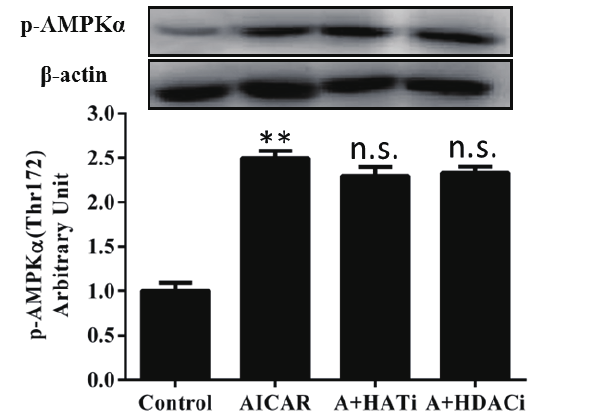
Figure 1. Antemortem injection of AICAR activated AMPK in muscle as evidenced by increased phosphorylation of AMPK α at Thr172. AICAR, 5-Aminoimidazole-4- carboxamide1- β -D-ribofuranoside; AMPK, AMP-activated protein kinase; A+HATi, AICAR plus histone acetyltransferase inhibitor II; A+HDACi, AICAR plus histone deacetylase inhibitors. ** p<0.01 compared with control group; ns, not significant compared with AICAR-injected group. n = 8.